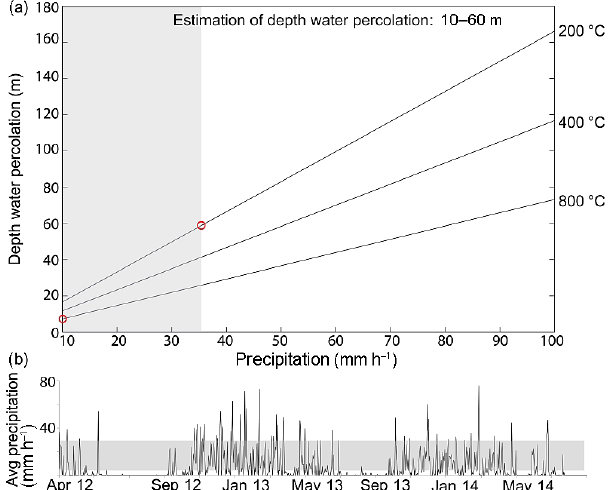
Figure 6. (a) Depth of rainwater percolation, as a function of rain- fall intensity at Merapi, is controlled by the temperature of the dome. By assuming the minimum and maximum temperature of the dome of 200 and 800 ◦ C, respectively, the estimation of depth water percolation is 10 to 60m (red circles) during typical rainfall (grey area). (b) The typical intensity of rainfall from April 2012 to July 2014 was 10–35mmh − 1 (grey area) and was calculated based on average rain intensity from five observatories near Merapi (see Fig.